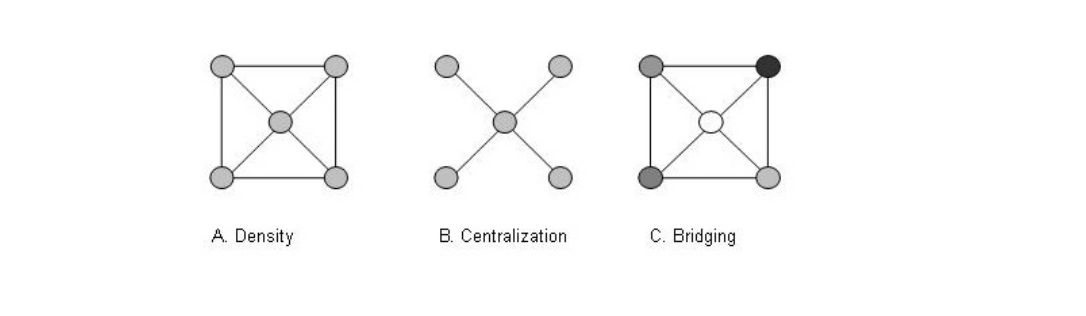
Fig. 2. Different network